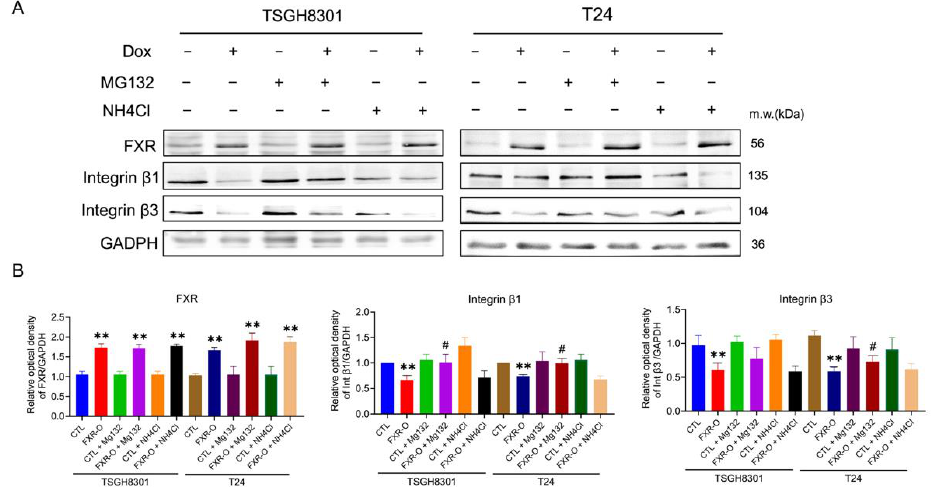
Figure 5. The effect of MG132 and NH4Cl on integrin expression after FXR overexpression. ( A ) Integrin β 1, integrin β 3, MLC and p-MLC were analyzed by Western blotting in the TSGH8301 and T24 cells with or without MG132 or NH4Cl. GAPDH was used as the loading control. ( B ) The bar graphs show the relative quantitative analysis of the aforementioned proteins. ** p < 0.01 compared with the control group; # p < 0.05 compared to the FXR-O group.